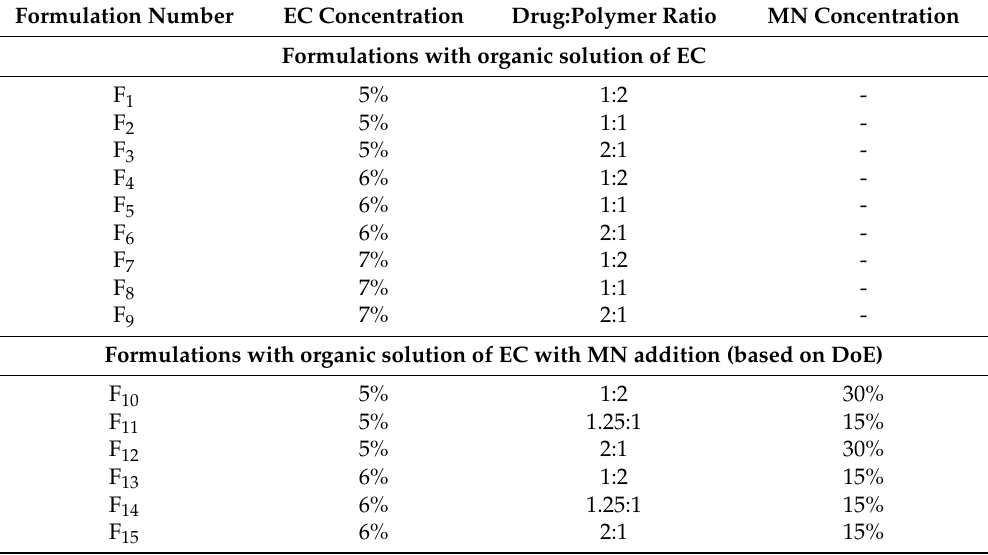
Table 2. Composition of designed formulations obtained with organic solutions of EC (F 1 –F 9 ), with